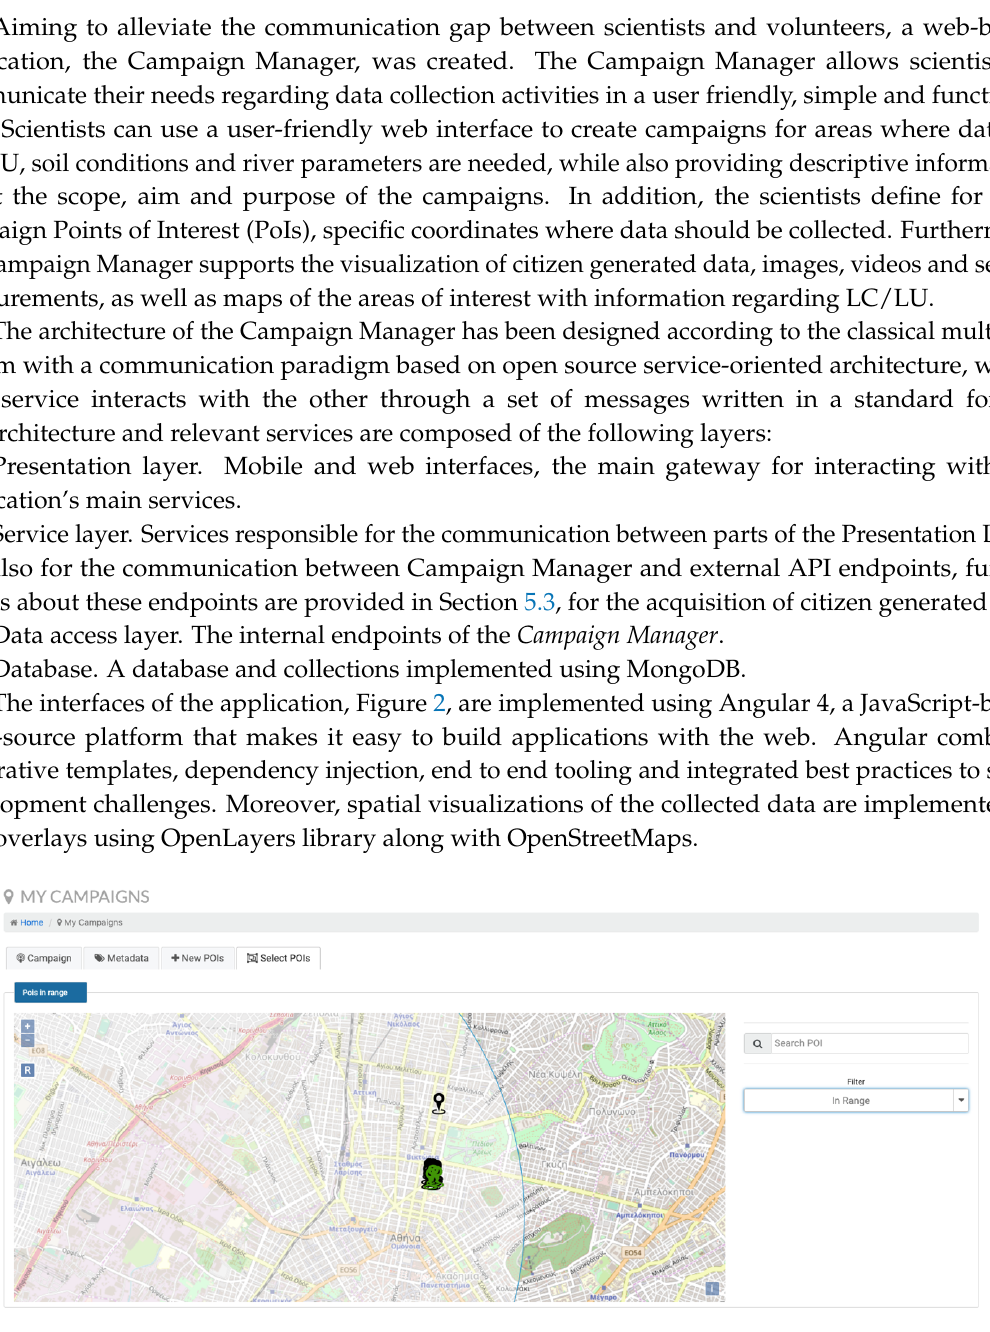
Figure 2. Campaign Manager. PoI